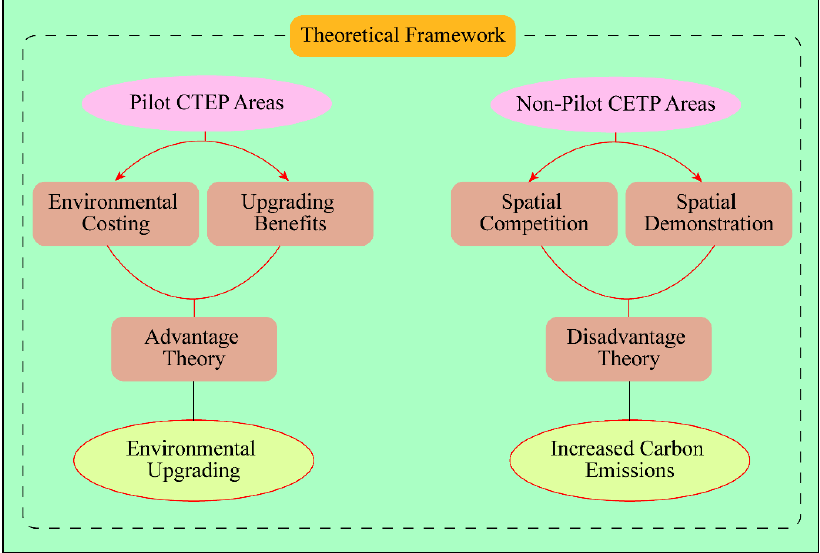
Figure 4. Theoretical